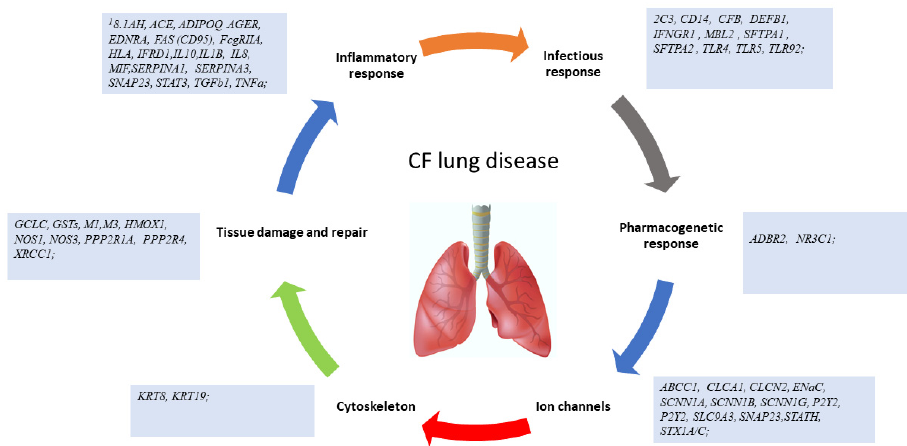
Figure 4. Pathogenic mechanisms correlated with the severity of CF lung disease.